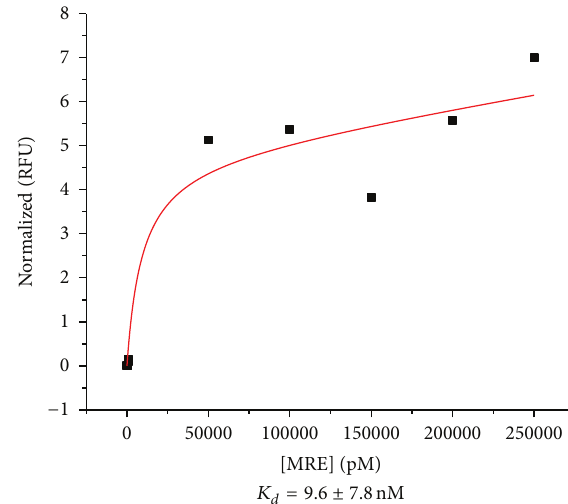
Figure 4: Affinity binding assays of R13.2. Top is a representative saturation binding curve of R13.2 with nonlinear regression best fit. Bottom is the equilibrium dissociation constant ( 𝐾 𝑑 ) of R13.2 and bromacil (average of three experiments ± standard